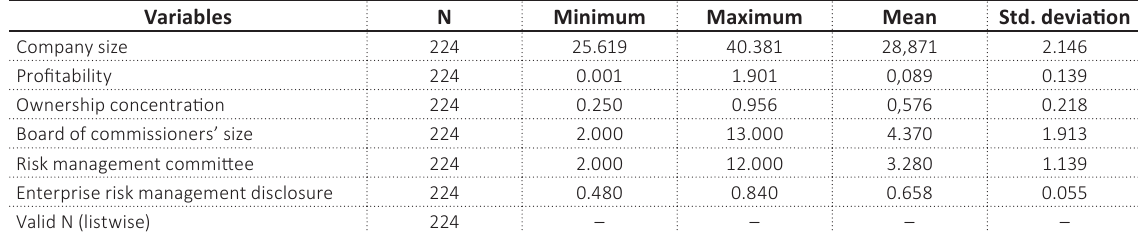
Table 1. Descriptive statistical analysis